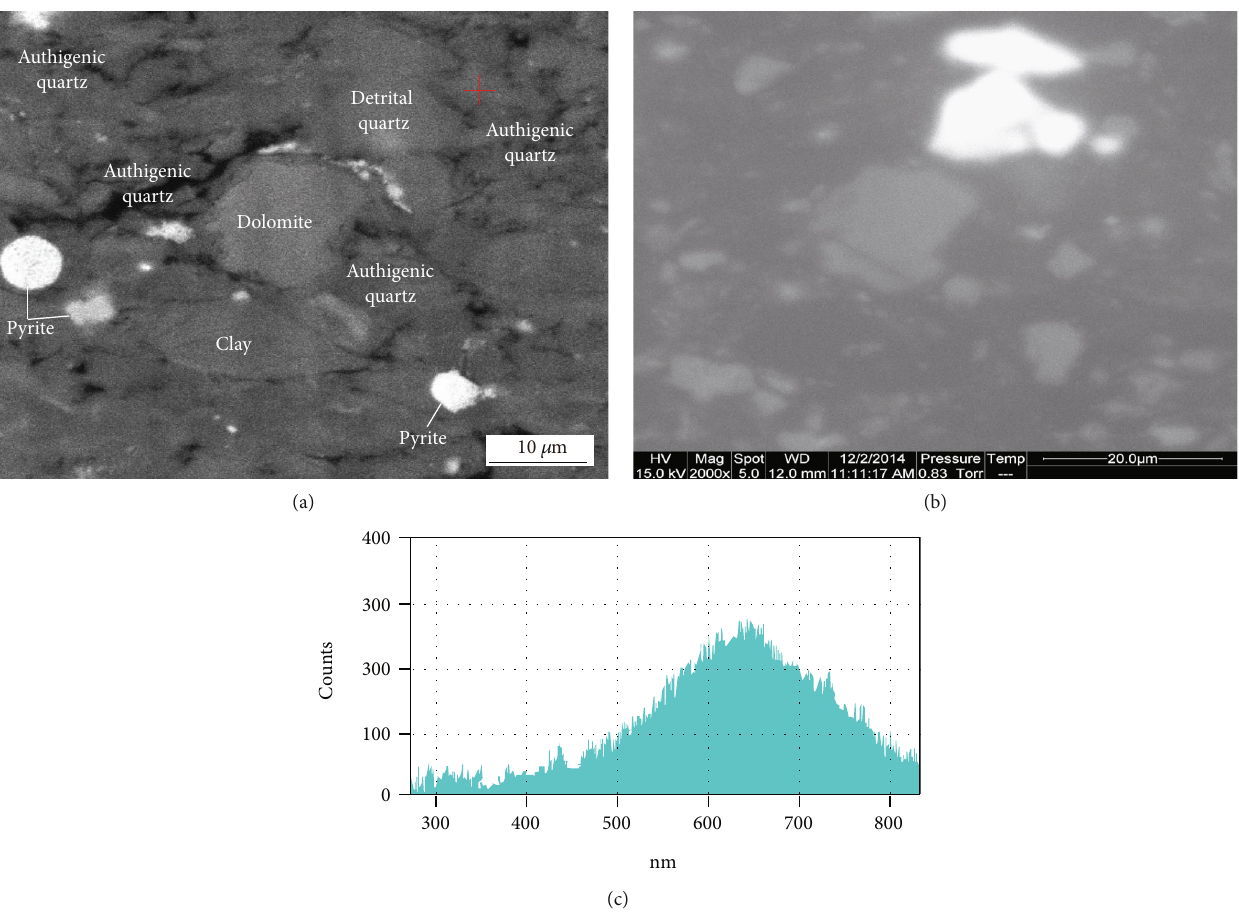
Figure 7: BSE images, cathodoluminescence (CL) image, and CL-response images of siliceous shale samples from the Wufeng and Longmaxi Formations. (a) BSE image of detrital quartz silt with pore- fi lling authigenic quartz, Longmaxi Formation, 2565.85m, well JY 2. (b) SEM-CL image reveals that quartz silt grains have strong luminescence. In contrast, microcrystalline quartz is essentially nonluminescent, suggesting a diagenetic origin. (c) Monochromatic CL-responses of microcrystalline quartz (red cross in